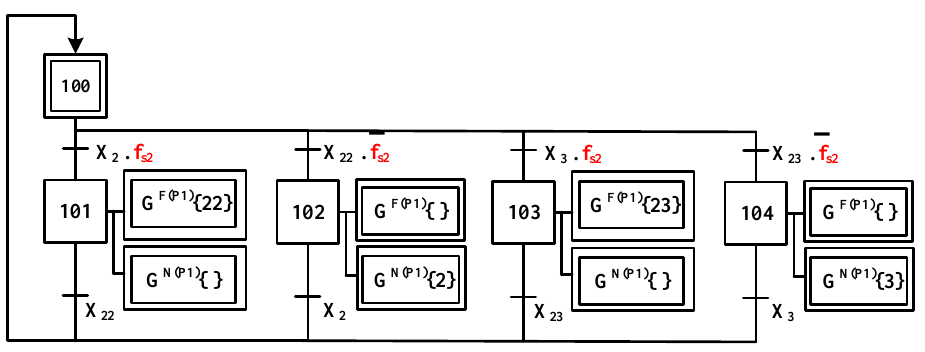
Figure 16. Grafcet interpretation of reconfiguration rules.